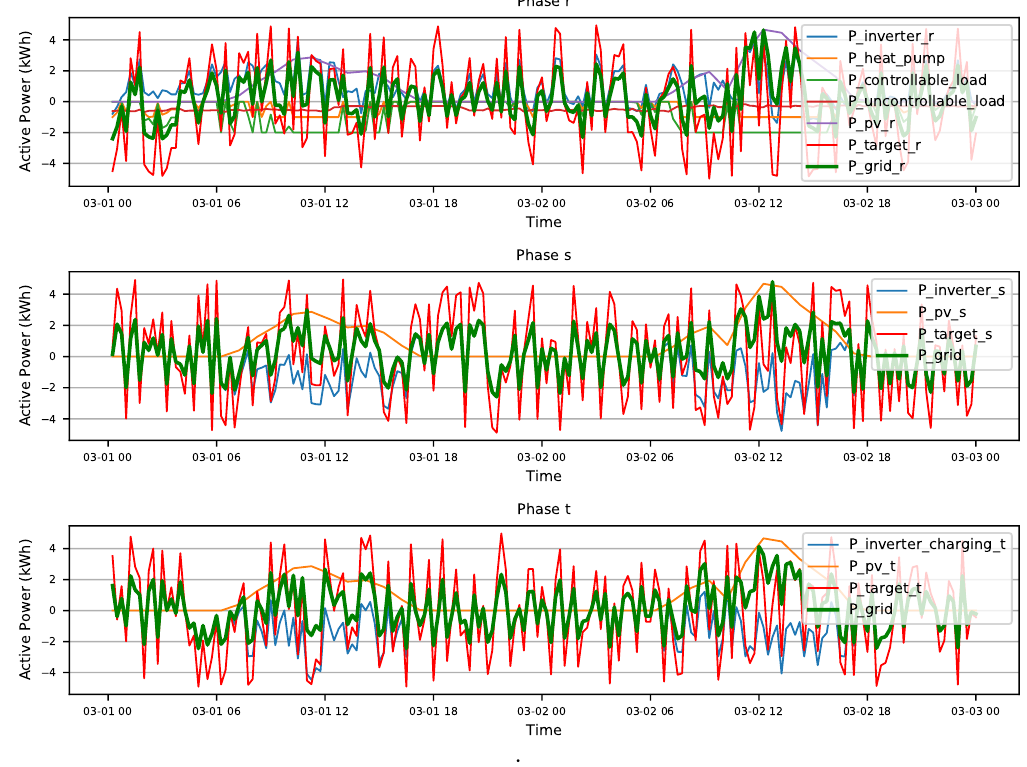
Figure 11. Per-phase active power controllable and disturbance variables for passive house and weight scenario ( S , U , G ) = ( 0,0,1